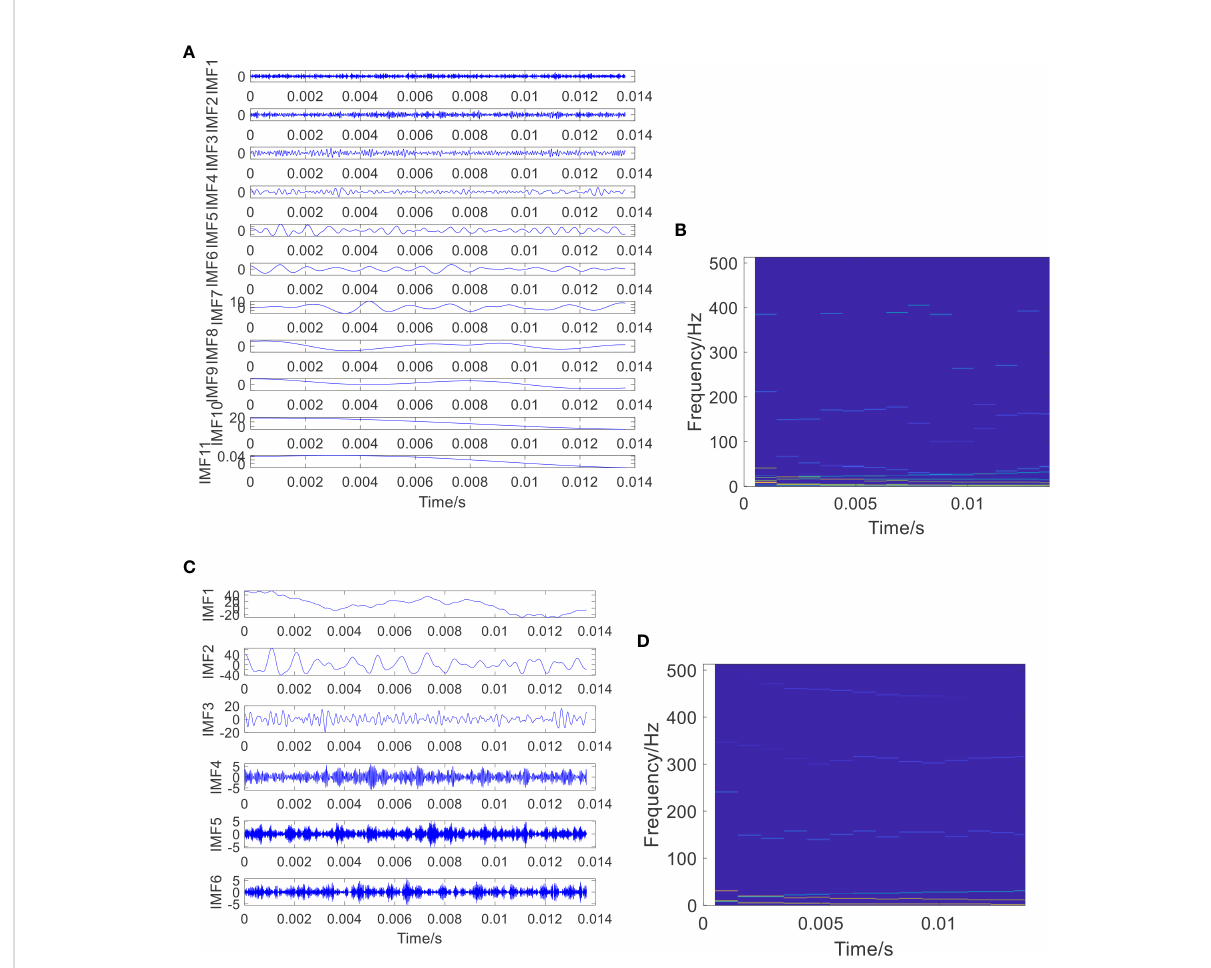
FIGURE 15 The estimated signal components and their estimated time – frequency plots using the EEMD and VMD methods. (A) The estimated components using the EEMD method; (B) the estimated time – frequency plot of the estimated components using the EEMD method; (C) the estimated components using the VMD method; and (D) the estimated time – frequency plot of the estimated components using the VMD